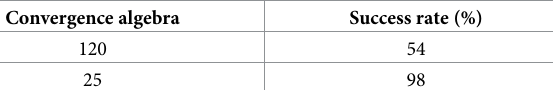
Table 4. Algorithm comparison results.